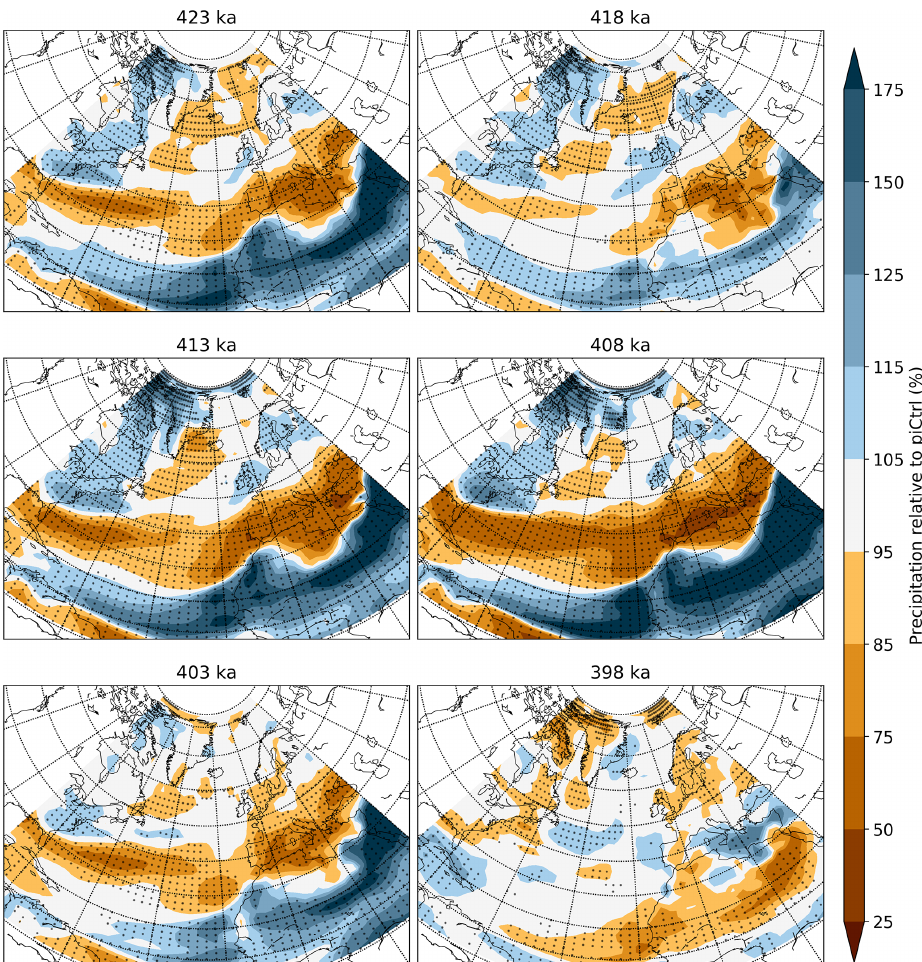
Figure 10. Time slice mean summer precipitation anomalies across the North Atlantic throughout MIS-11, indicating slight increases in precipitation on the western slope of Greenland with corresponding decreases in the southeast from 423 to 408ka. Stippled regions correspond to grid points significantly different from the preindustrial control simulation at the 95% confidence